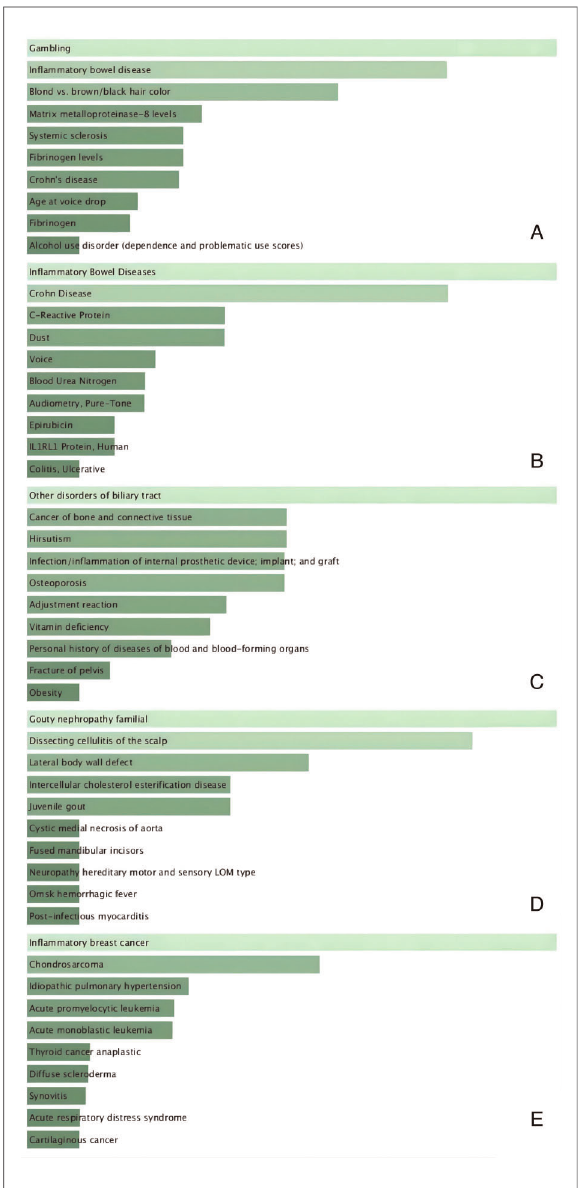
FIGURE 9 Disease enrichment plot. ( A ) GWAS_Catalog_2019, ( B ) PhenGenI_ Association_2021, (C) PheWeb_2019, ( D ) Rare_Diseases_AutoRIF_ ARCHS4_Predictions, ( E ) Rare_Diseases_GeneRIF_Gene_Lists. Ranked by P -values. The genes in the brown module that were signi fi cantly enriched in in fl ammatory diseases, including in fl ammatory bowel disease ( A,B ); infection/in fl ammation of internal prosthetic device, implant and graft ( C ); post-infectous myocarditis ( D ); in fl ammatory breast cancer ( E